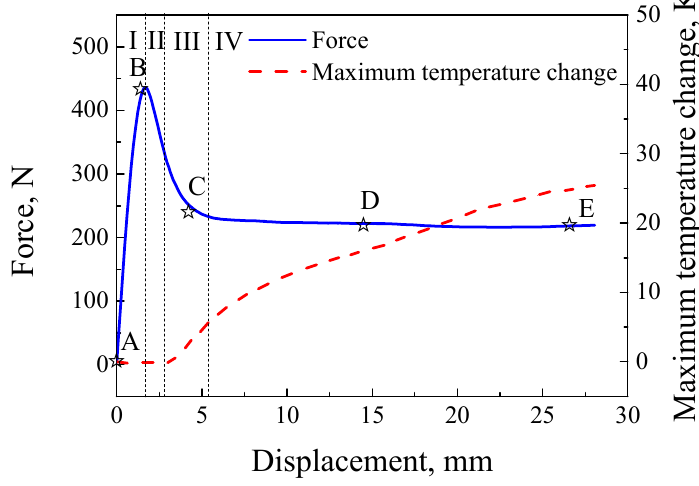
Figure 5. Illustration of loading partition.